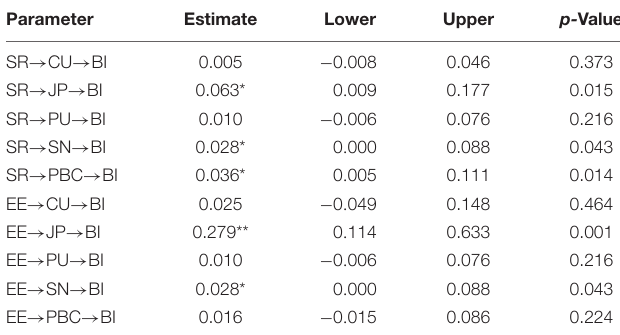
TABLE 3 | Model fit.